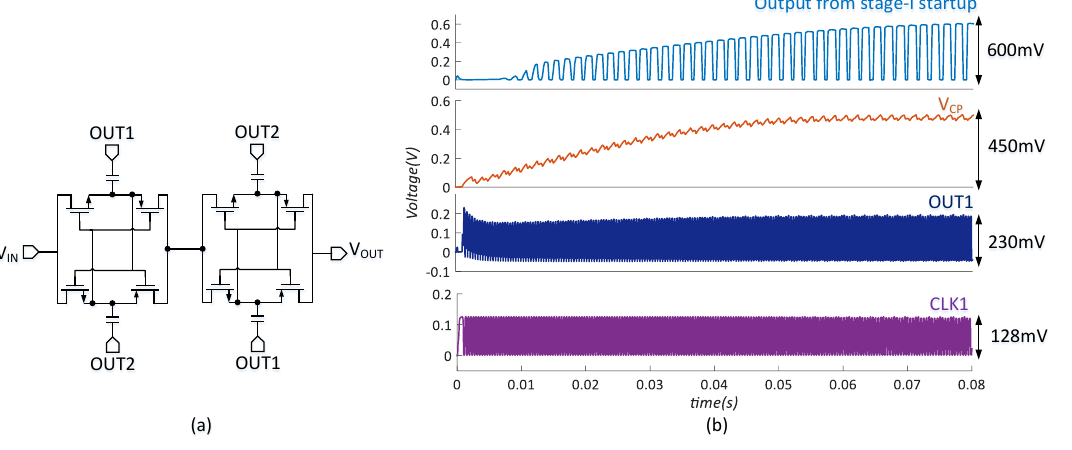
Figure 8. ( a ) The structure of each charge pump; ( b ) stage-I startup simulation waveform when V IN = 128 mV.